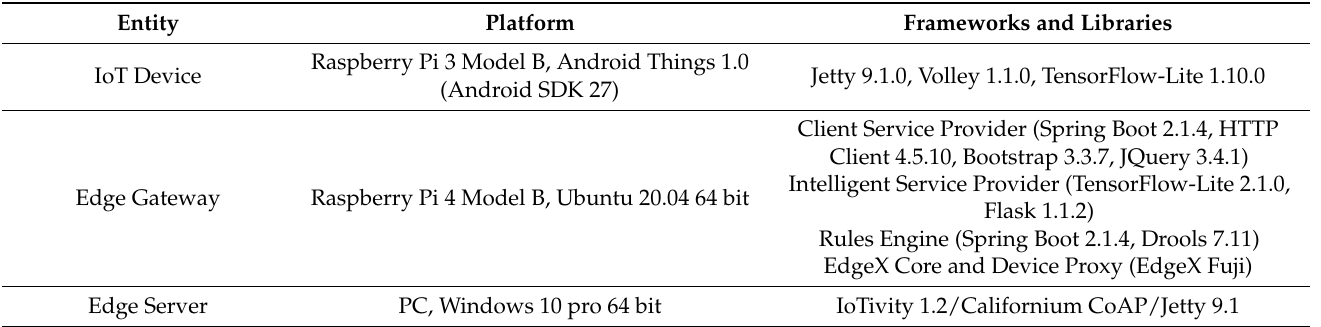
Table 1. Development Environment.